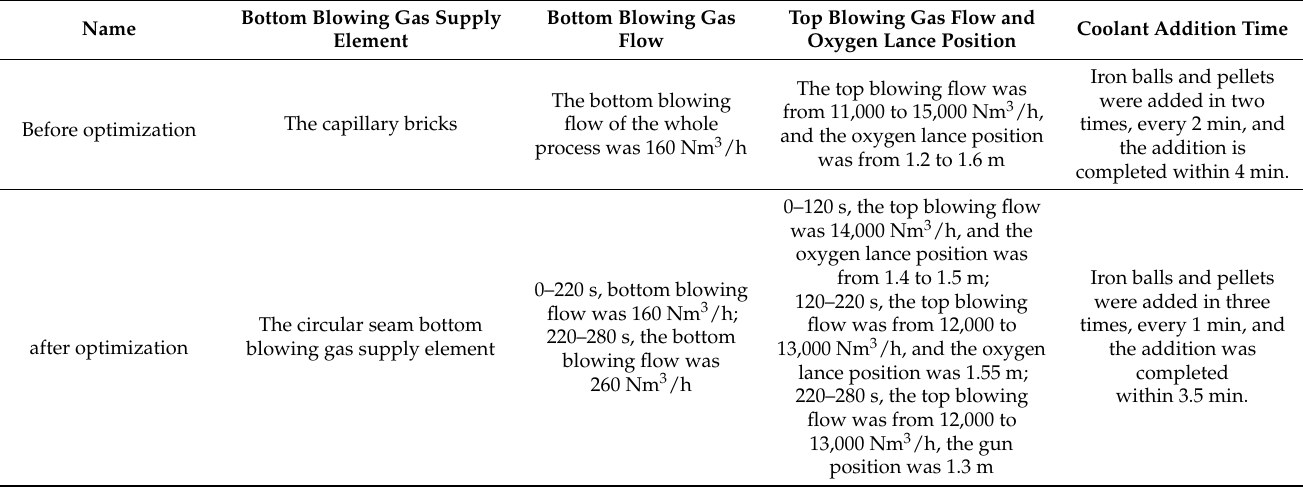
Table 4. Changes of blowing process before and after process